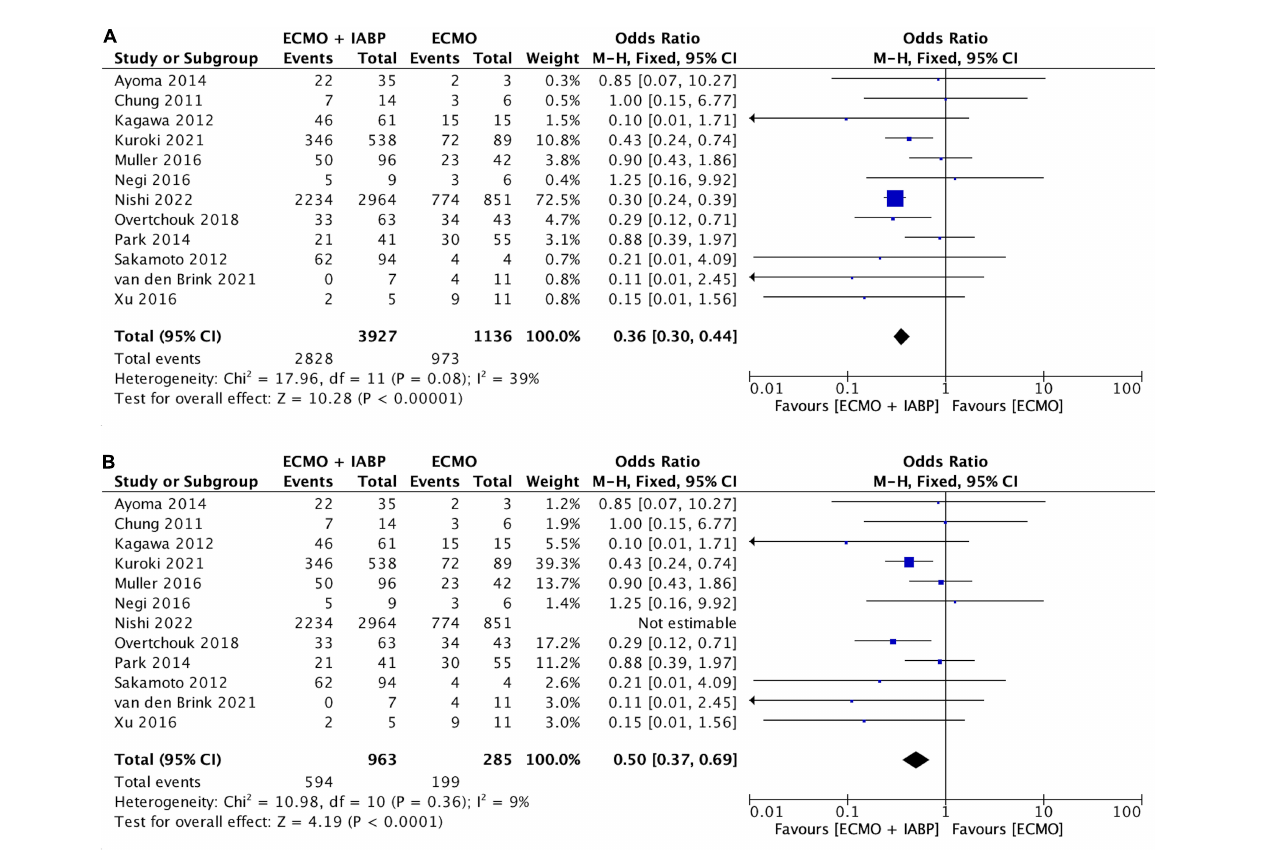
FIGURE2 Forest plot on 30-day survival ECMO + IABP vs. ECMO. (A) All included studies. (B) Subgroup analysis excluding Nishi et al. from 2022. Individual studies and pooled analysis showing a significant decreased 30-day mortality for patients in cardiogenic shock due to acute myocardial infarction treated with ECMO + IABP compared to patients with ECMO only ( p = 0.003). CI, confidence interval; OR, odds ratio.